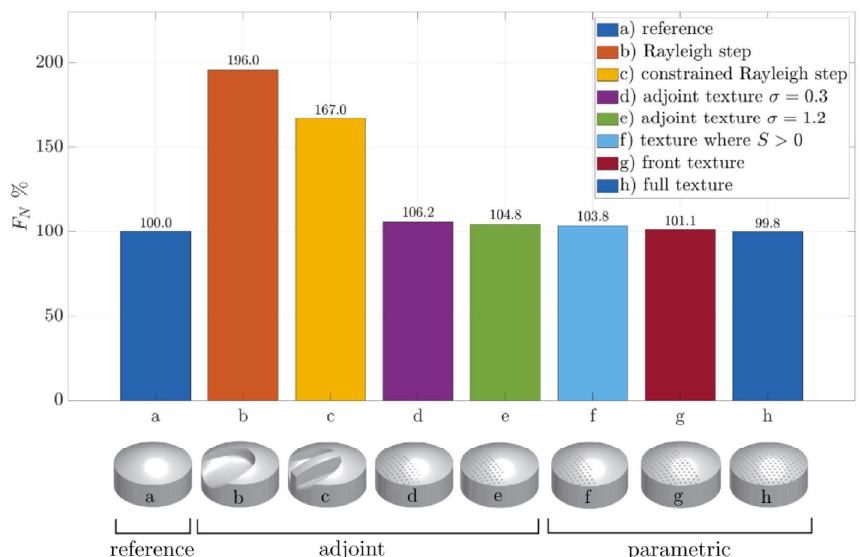
Fig. 59 Performance of the adjoint optimization for different constraints [878]. Reproduced with permission from Ref. [878], © The author(s),